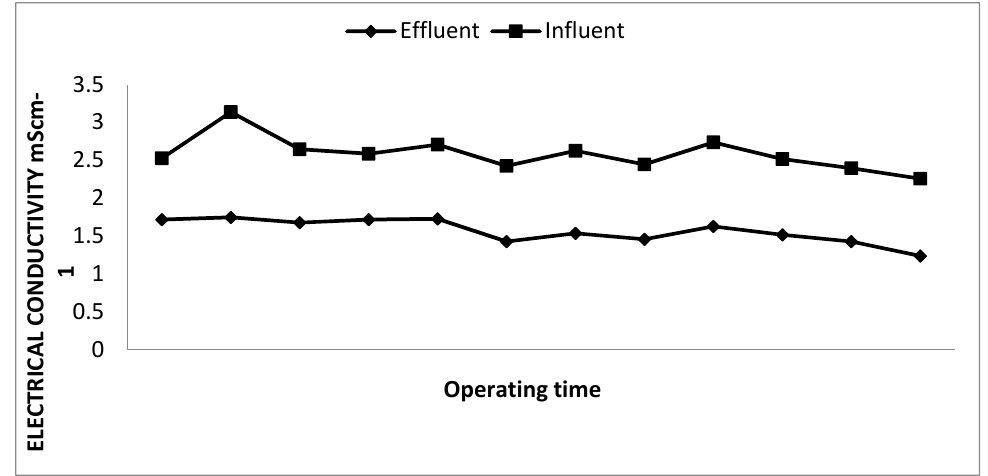
Figure 2. Efficiency of a trickling filter in removing electrical conductivity from an anaerobic digester effluent.